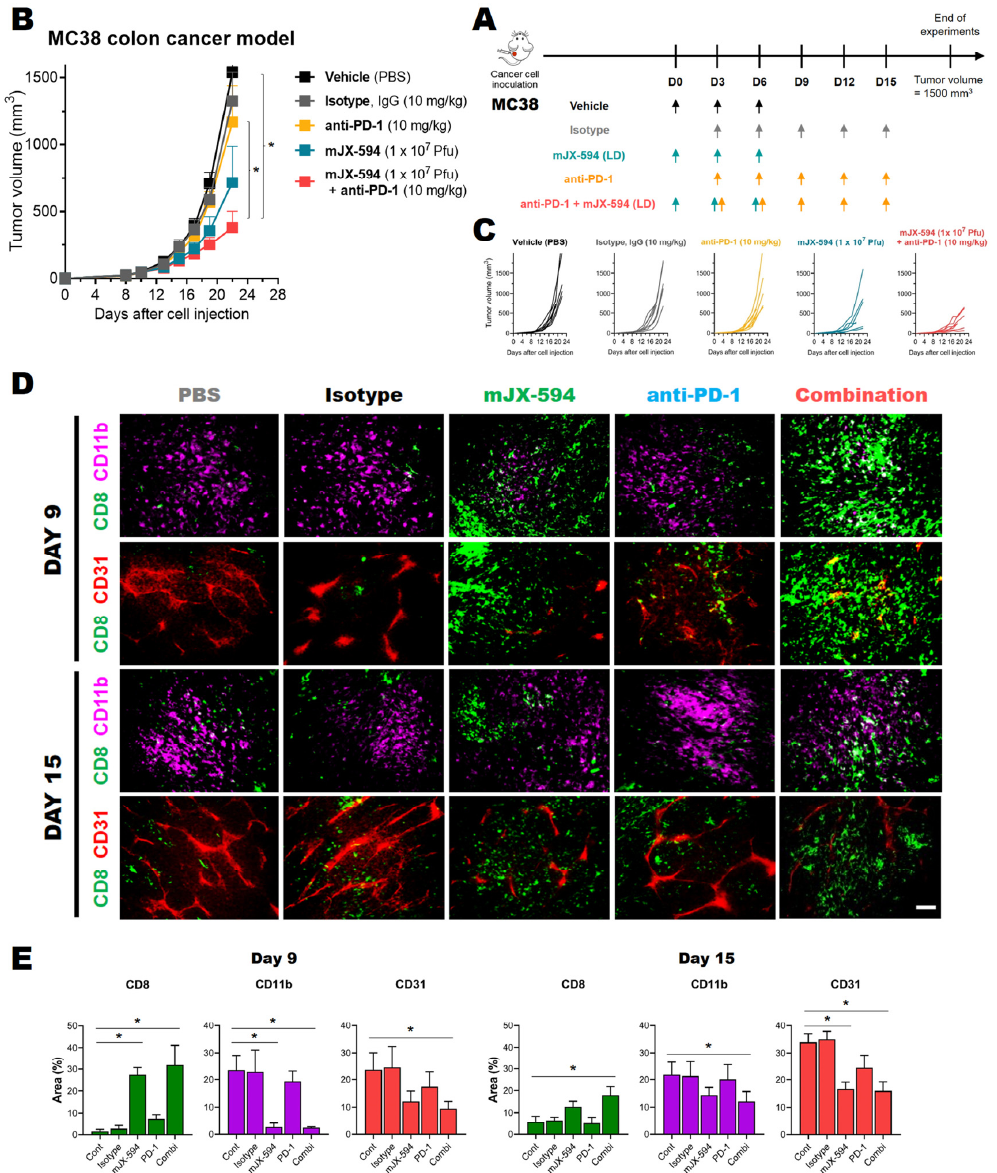
Figure 4. Combination treatment of anti-PD-1 with mJX-594 increased anti-tumor effects in a MC38 colon cancer model. ( A ) Combination treatment strategy. MC38 cancer cells were subcutaneously implanted into C57BL/6 mice. When tumors reached 50–60 mm 3 in volume, mice were intratumorally administered 1 × 10 7 pfu of mJX-594 on days 0, 3, and 6. For combination therapy, anti-PD-1 antibody was intravenously injected five times at 3-day intervals, starting from the second treatment of mJX-594. Tumor growth monitoring until the end of the experiment (tumor volume ≤ 1500 mm 3 ), and immunofluorescence microscopy images showing changes in immune cell infiltration on days 9 and 15 after the first mJX-594 treatment in MC38 tumor tissue. ( B ) Average tumor growth curve of MC38 tumor-bearing mice after mJX-594 and anti-PD-1 combination treatment ( n = 7 per group). Group comparisons of tumor growth were carried out by two-way ANOVA with Bonferroni correction. Values are mean ± SEM. * p < 0.05. ( C ) Individual tumor growth curves of MC38 tumor bearing mice after mJX-594 and anti-PD-1 combination treatment. ( n = 7 per group) ( D ) Representative images of CD8 + T cells, CD31 + blood vessels, CD11b + myeloid cells in tissue sections. Scale bars, 200 mm. ( E ) Percentage of area infiltrated with leukocytes relative to the whole tumor, calculated using ImageJ software on days 9 and 15 after the first mJX-594 treatment. * p < 0.05. Two-tailed Student’s t -test was used for the